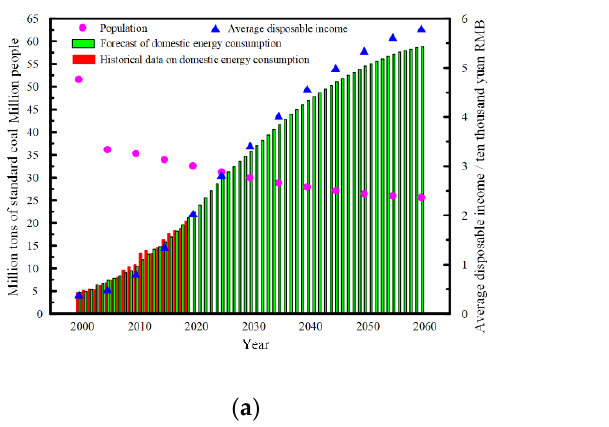
Figure 6. ( a ) Rural population size, rural per capita disposable income and household energy consumption forecast in Guangdong; ( b ) Total power of agricultural machinery, total output value of agriculture, forestry, livestock and fishery, and energy consumption for production forecast in Guangdong. From Guangdong Rural Statistical Yearbook (2001–2020) [13].